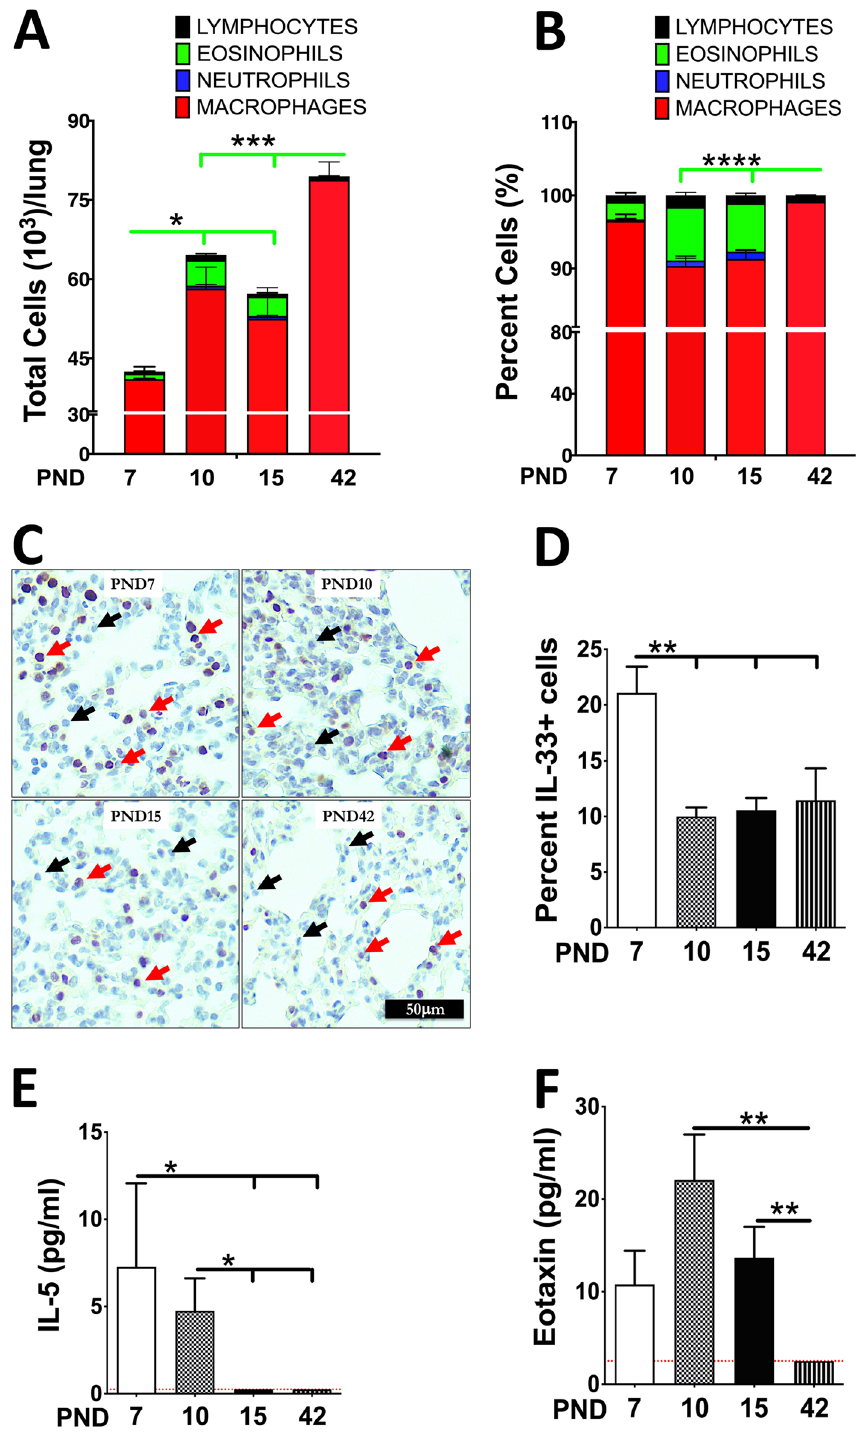
Figure 1. Airspace eosinophilia in the developing lungs of mice. Cell counts in BALF from mice at the age of postnatal day (PND) 7, 10, 15, and 42 (n = 5–10 per group). Differential cell counts ( A ) and relative percentages of constituent cell types ( B ) are shown as stacked bar graphs [macrophages (red), neutrophils (blue), eosinophils (green), and lymphocytes (black)]. Representative images of lung sections that were immunohistochemically stained for IL-33 (Red arrows; IL-33-stained cells, Black arrows; unstained cells) ( C ). Image J quantification of IL-33 immunostained sections (n = 5–6 per group) ( D ). Cytokine levels (pg/ml) of IL-5 ( E ) and Eotaxin ( F ) in cell-free BALF of mice at PND 7, 10, 15, and 42 (n = 5 per group). Error bars represent SEM. * p < 0.05, ** p < 0.01, *** p < 0.001, **** p < 0.0001 using ANOVA followed by Tukey’s multiple comparison post hoc test. The lower limits of detection (indicated by red dotted lines) for IL-5 and Eotaxin were 0.25 pg/ml and 2.51 pg/ ml, respectively. The results represent cumulative data on mice generated in two to three different